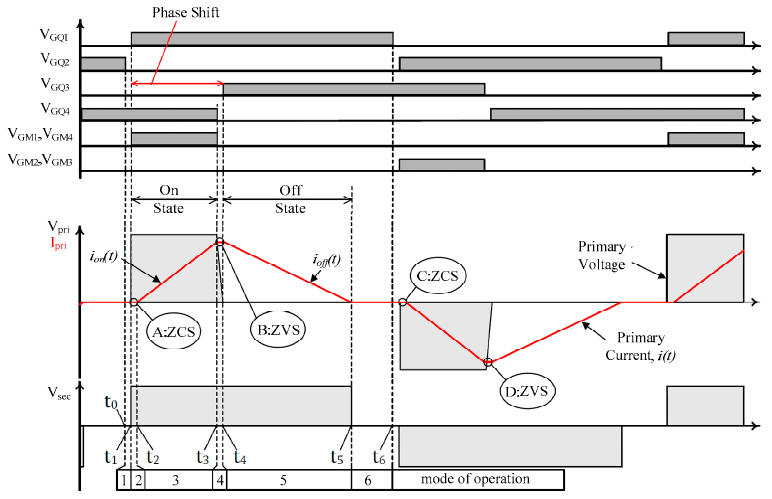
Figure 2. Gate Drive Signals of Proposed Control Method.